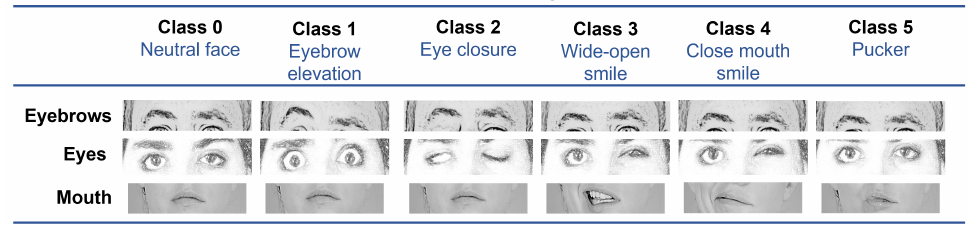
Figure 4. The proposed facial gestures grouped into six